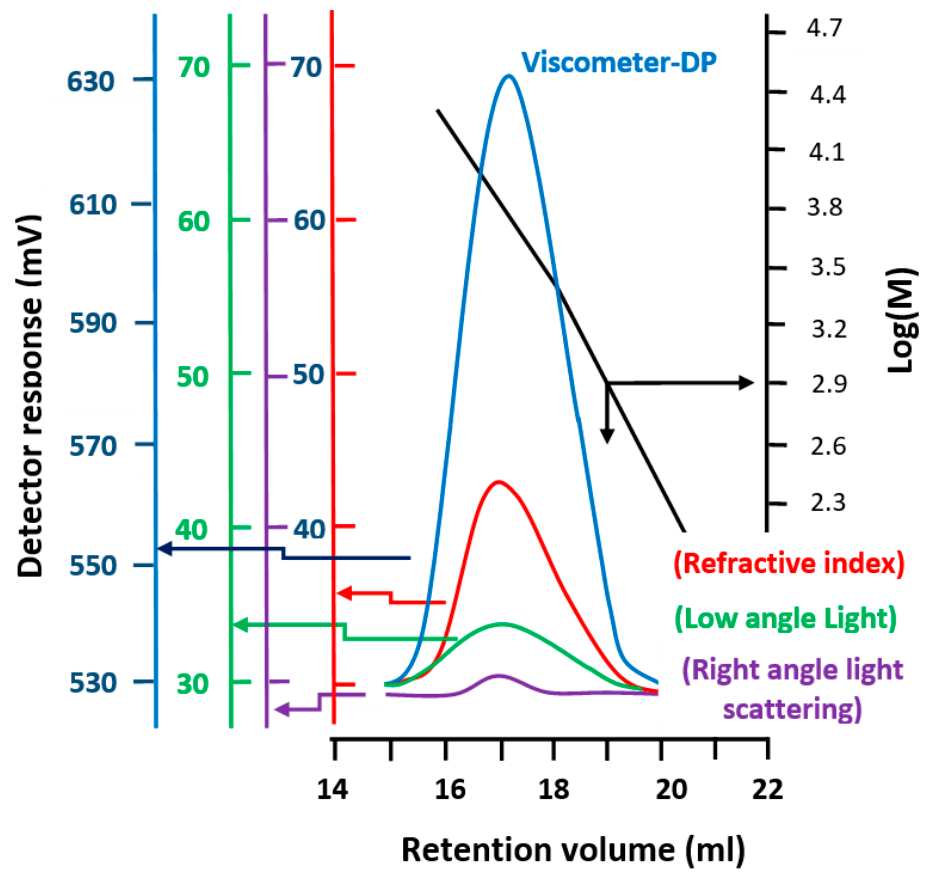
Figure 5. Data treated from the SEC chromatogram of PEUGMA as example of synthesized polymers.